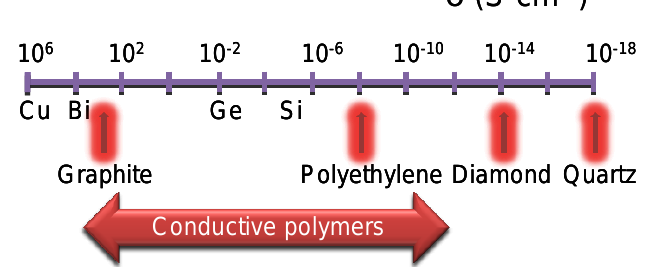
Figure 1. The diagram illustrating conductivity σ (S·cm −1 ), which compares polyethylene oxide with other